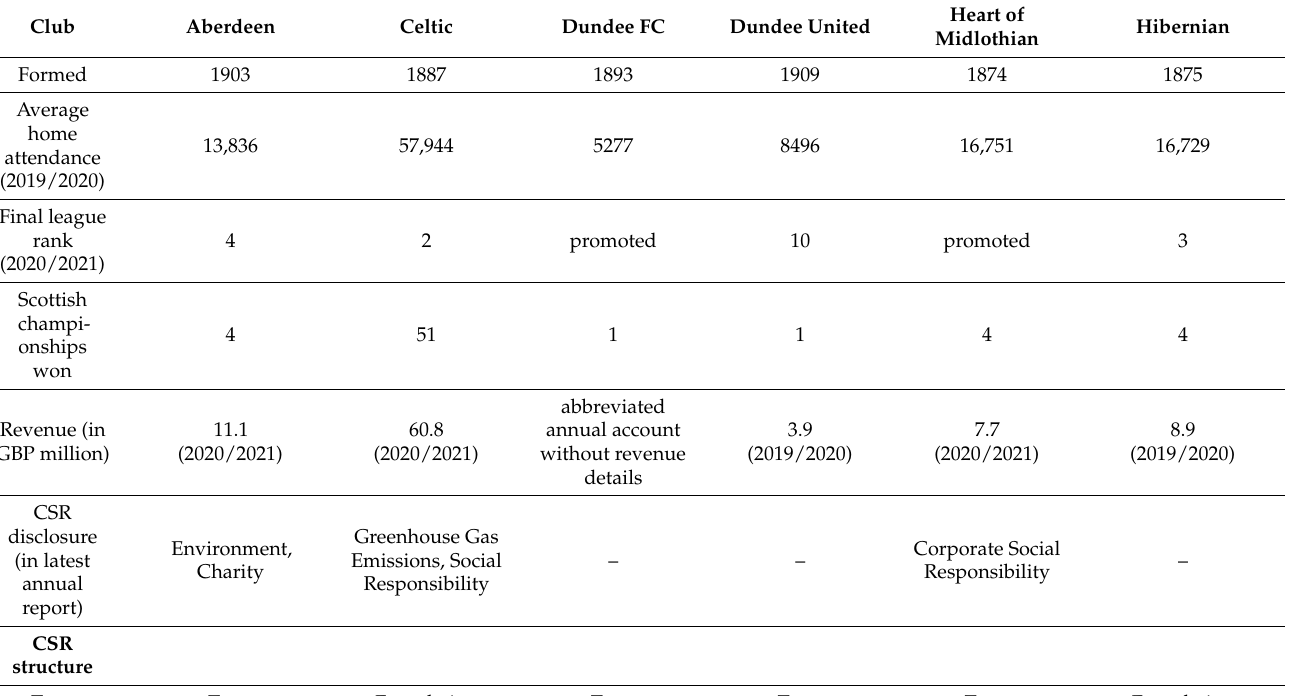
Table 3. Premiership clubs and their CSR structures—Part 1 (based on websites of clubs, their charities, OSCR, EFDN, SPFL Trust, Transfermarkt.de and annual